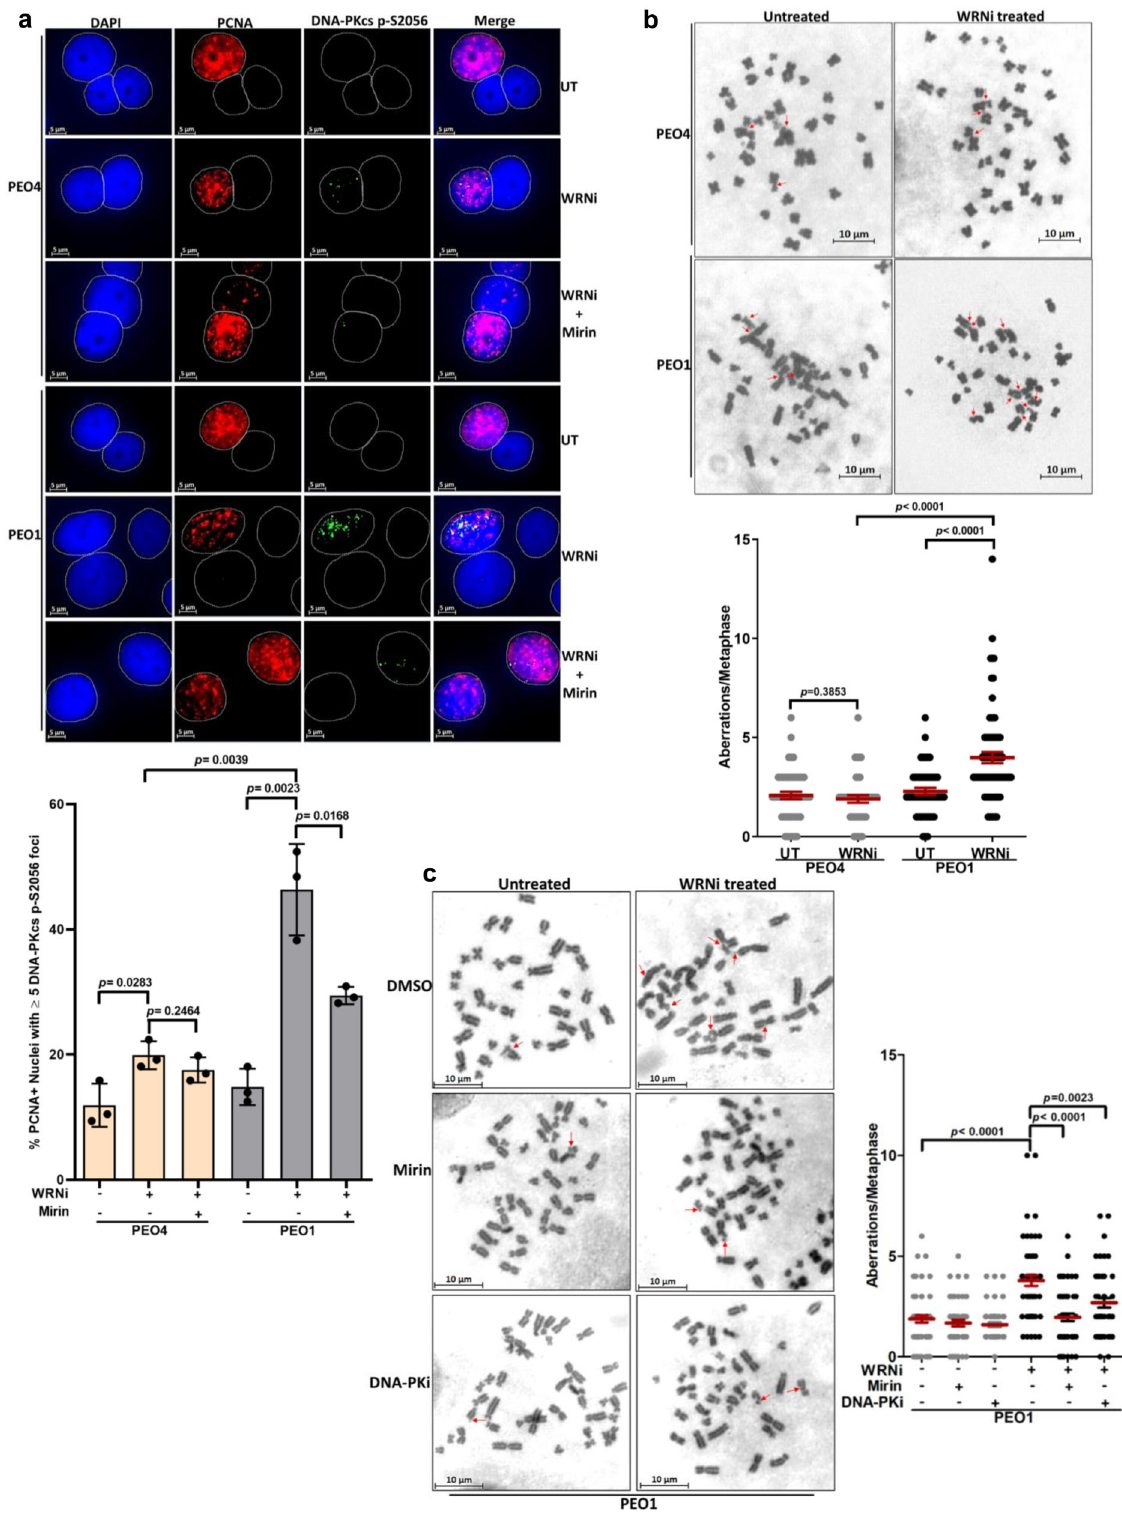
Effect of NSC617145 on BRCA2 -de fi cient tumor growth and DNA damage in vivo . Given the observed hypersensitivity of a broad range of BRCA2-defective cancer cells to NSC617145, we tested the in vivo response of BRCA2 -de fi cient tumors to the WRNi using xenograft tumor models in athymic nude mice (Fig. 8c). Mice carrying DLD1 WT or BRCA2 − / − tumors